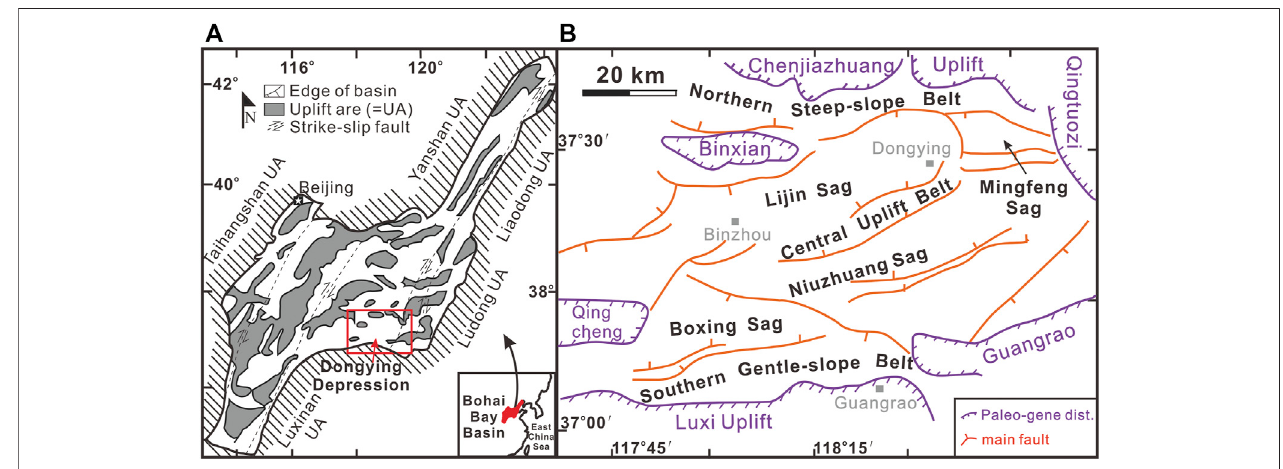
FIGURE 1 | Regional geological setting of the study area. (A) Location of the Dongying Depression, Bohai Bay Basin, east China. (B) Tectonic framework of the Dongying Depression.